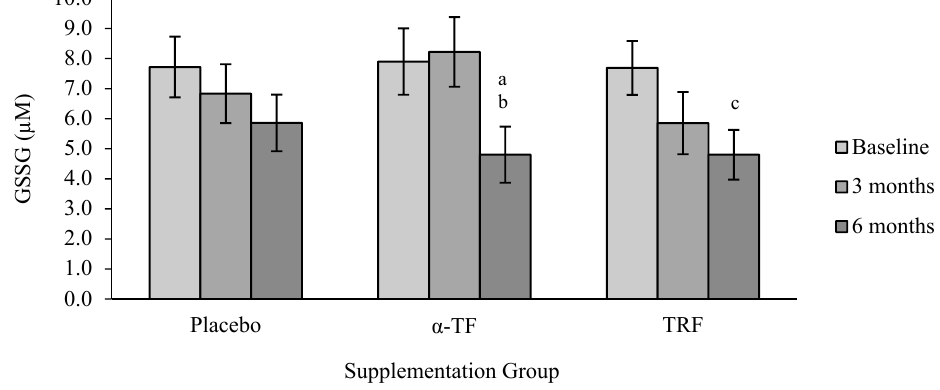
Figure 9. Effect of α -TF and TRF supplementation on oxidized glutathione (GSSG) concentration for 6 months. a = significantly different compared to 0-month α -TF, b = significantly different compared to 3 months α -TF, c = significantly different compared to 0 month TRF, p < 0.05.